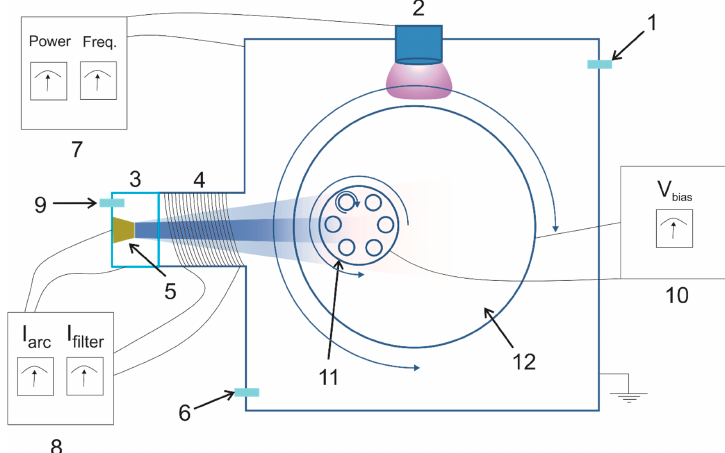
Figure 1 Figure 1. Schematic view of the deposition system (1—vacuum cryopump inlet, 2—3”WS 2 sputtering target, 3—anode, 4—linear filter, 5—graphite cathode, 6—sputtering argon inlet, 7—PVD sputtering power unit, 8—cathodic arc power unit, 9—cathodic arc argon inlet, 10—substrate bias power